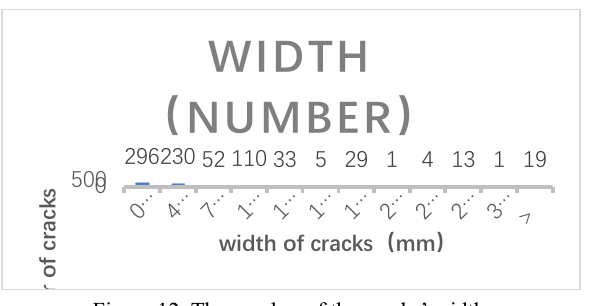
Figure 12. The number of the cracks’ width.